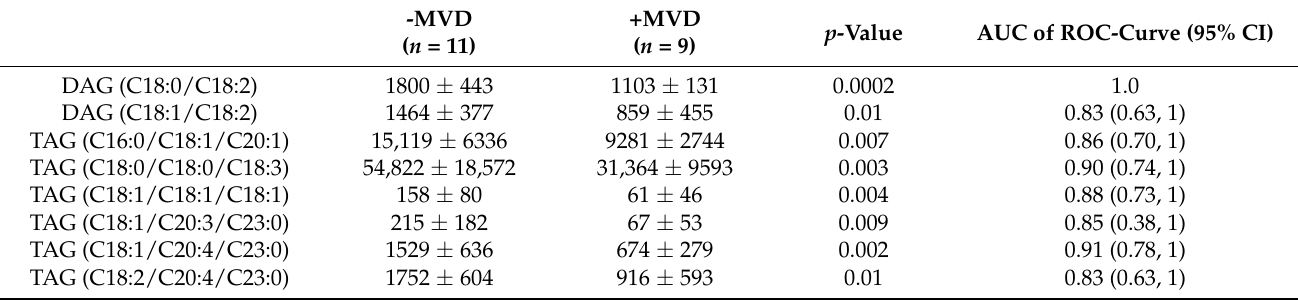
* All values are expressed in peak intensity and are shown as mean ± STD. p -values for ROC-curves were obtained by a Kruskal–Wallis test; only plasma lipid species are shown that differ at p ≤ 0.01. C, fatty acid carbon chain length; 95% CI, 95% confidence interval; DAG, diacylglycerol; MVD, microvascular dysfunction; AUC of ROC-value, area under the curve of receiver operating characteristic; TAG,